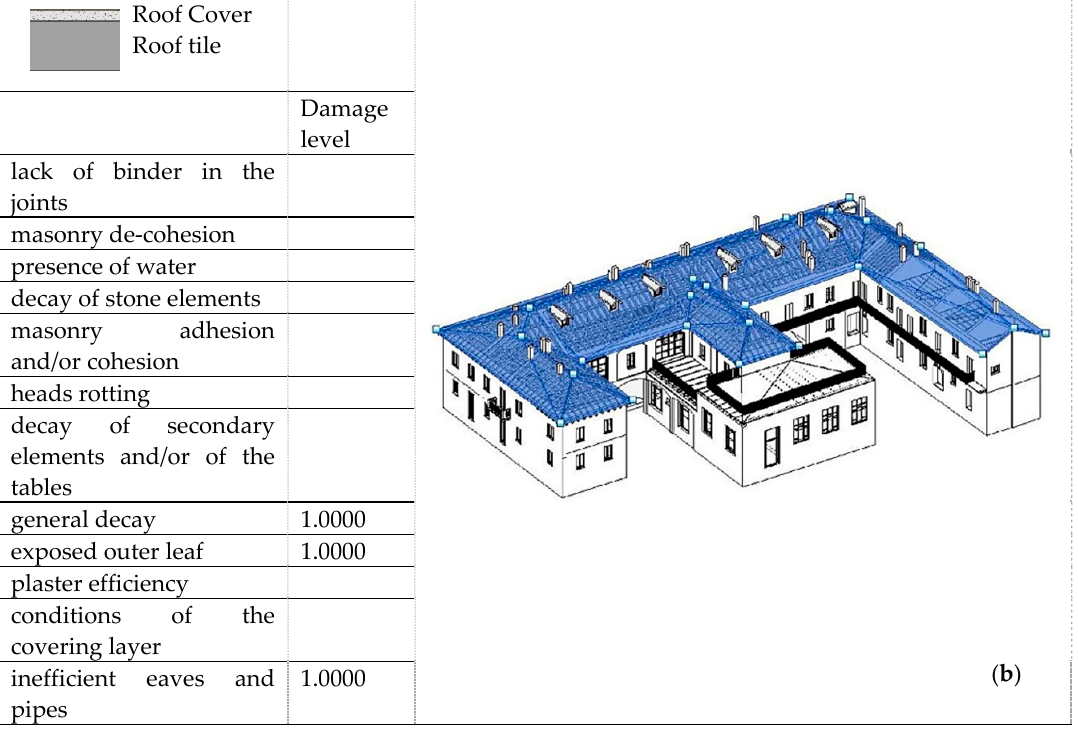
Figure 9. Example of coupling between structural element, specific vulnerability, and associated weights: ( a ) masonry wall thickness; ( b ) roof cover.